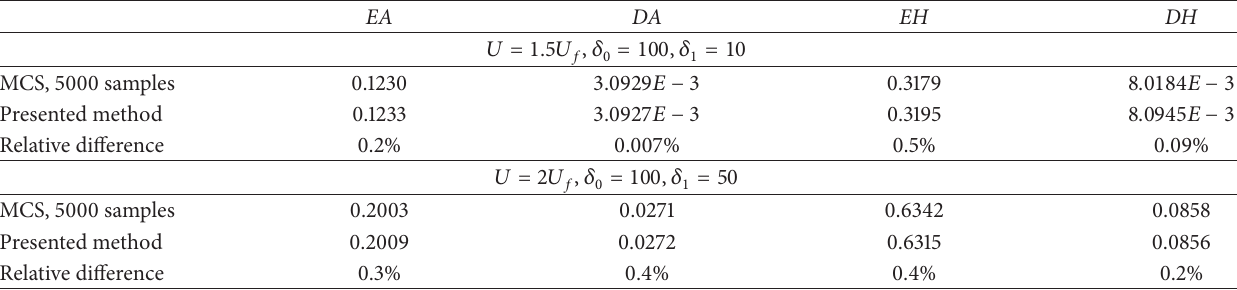
Table 4: Comparisons between the mean and standard derivation by the presented method and by MCS.